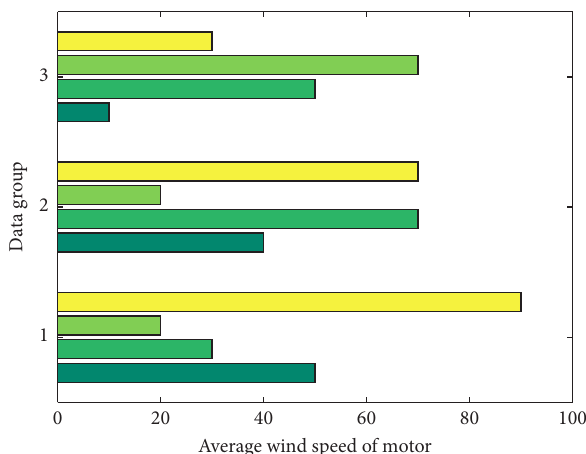
Figure 5: Histogram of the average value of unit speed data.